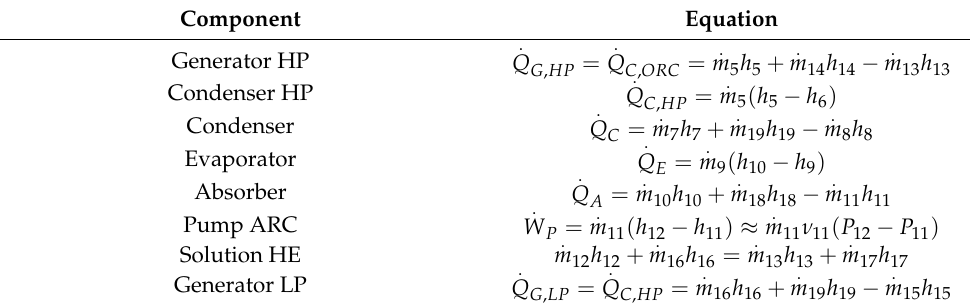
Table 2. Energy balance for the